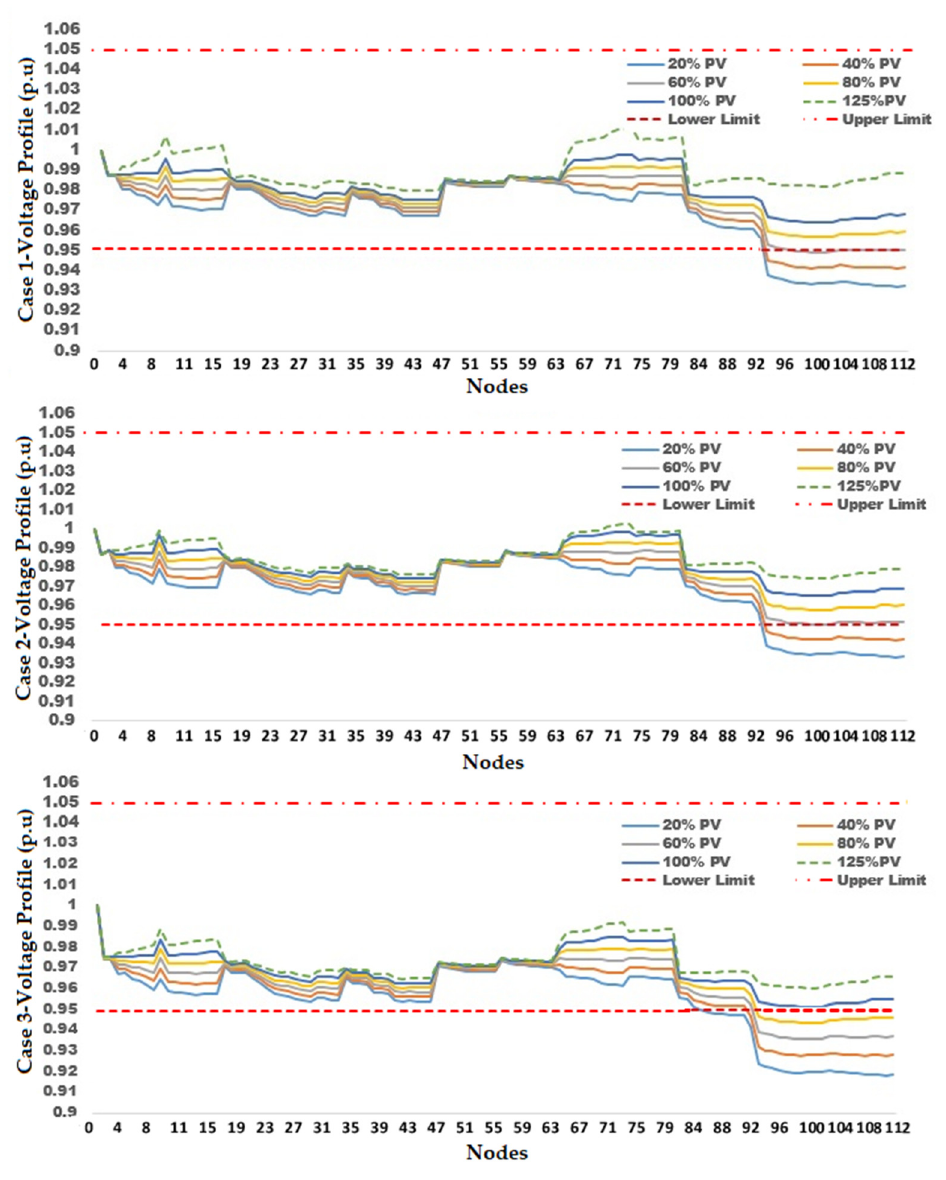
Figure 4. Comparison voltage profile all the busbars under peak load conditions for all case studies. Table 2. A comparison of power losses during period of peak load among cases 1,2, and 3. Levels of Solar